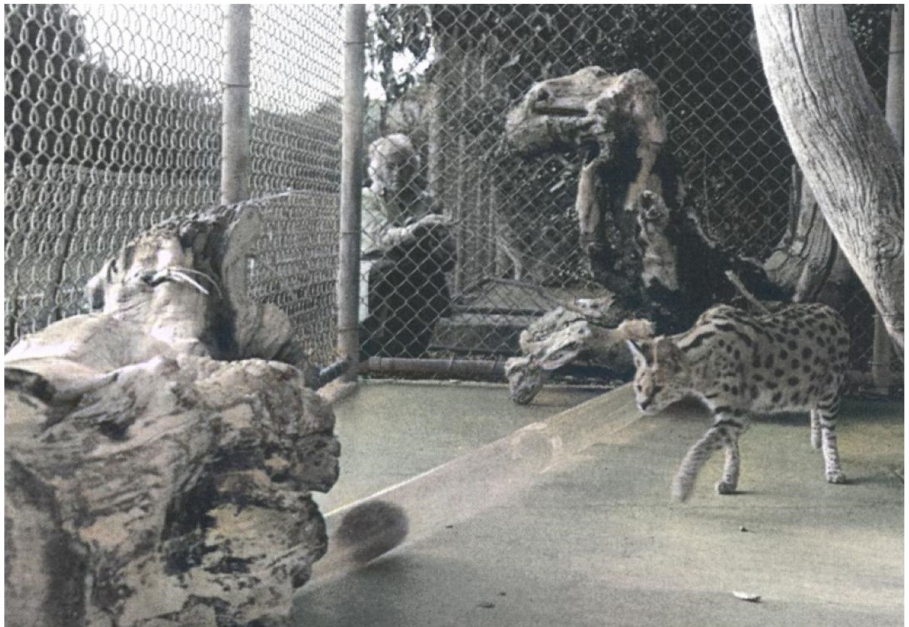
Figure 6. Colorized photo of a serval chasing artificial prey at the San Francisco Zoo, circa 1984. (Reproduced from [74] with permission of Elsevier,